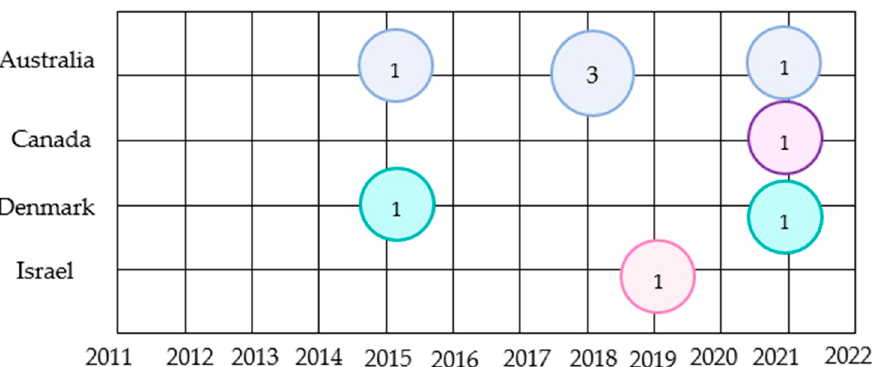
Figure 2. Shows the original publication years and countries of included articles (n = 9). Different colors of circles represent the countries. The circles correspond to the number of articles published the year and the in the year and the country.